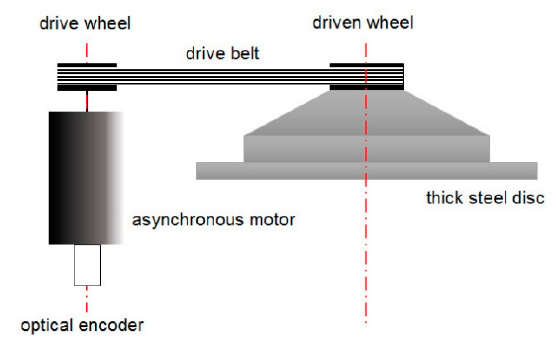
Figure 6. Schematic diagram of belt system.